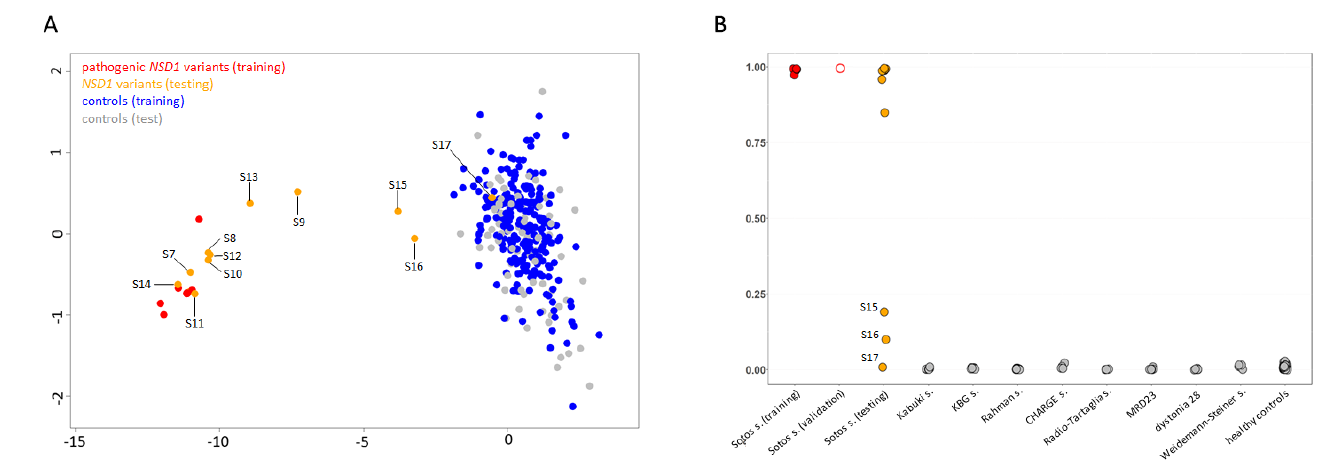
Figure 3. DNAm array analyses. ( A ) DNAm profiles in individuals carrying NSD1 variants versus a control cohort. Taking advantage of DNAm levels from the established episignature, MDS plot was used to test/validate sample clustering with respect to the Sotos syndrome training cohort (red, solid circles) and a control group including 295 healthy individuals and subjects with rare neurodevelopmental disorders (blue, solid circles). Tested VoUS are depicted in orange (solid circles), samples used for validation are shown in red (open circles), while control subset used for testing are in grey (solid circles). ( B ) Plot for SVM probability scores from the developed ML-based classifier, showing classification results for the tested samples (VoUS, n = 8, orange solid circles; validation samples, n = 3, red open circles), and the in-house control cohort (blue = training, grey = testing).